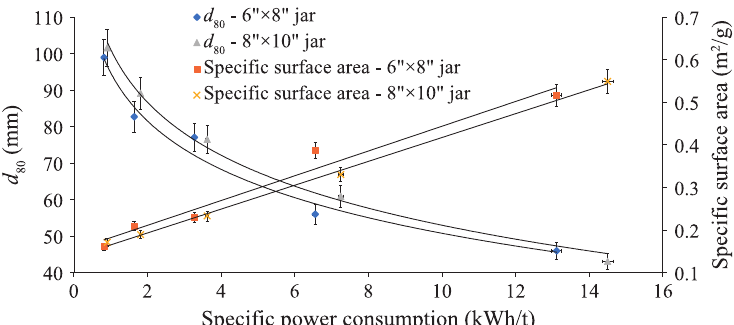
Fig. 3 Specific power consumption as a function of d 80 and specific surface area—Anglo American Minas Rio